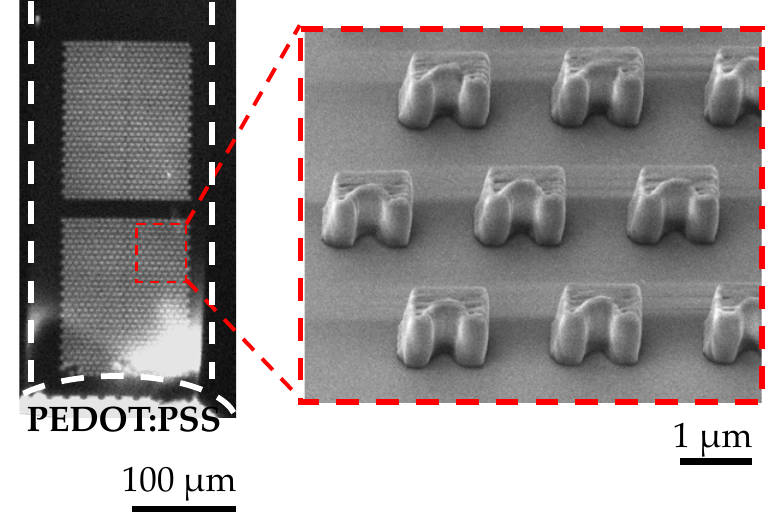
Figure 6. Trapping of preconcentrated extracellular vesicles with the microtraps on a glass surface for an initial concentration of 2.0 × 10 8 particles/1 mL at 45 V/cm. The microtrap was a semicircle of 2 µ m in diameter inscribed in a 4 µ m × 2 µ m (width × depth) rectangle. The height of the structure was ~4 µ